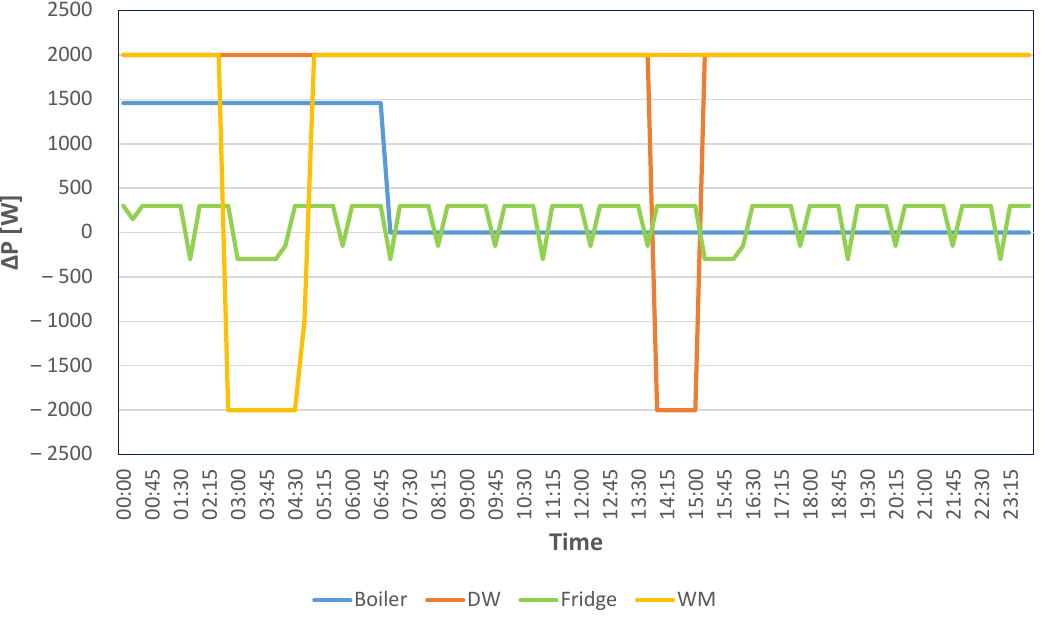
Figure 10. Updated flexibility diagrams after the first DR action.